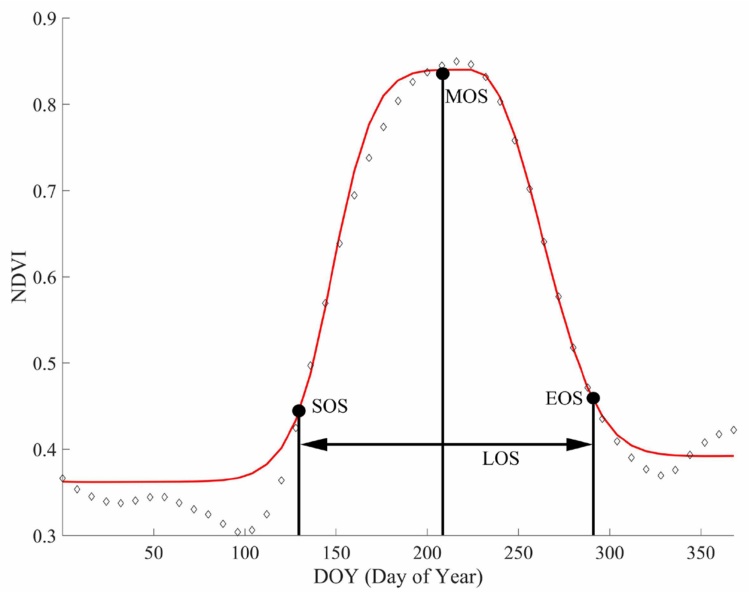
Figure 4. The asymmetric Gaussian function was used to fit the NDVI curve. Additionally, the dynamic threshold method was used to extract vegetation phenological